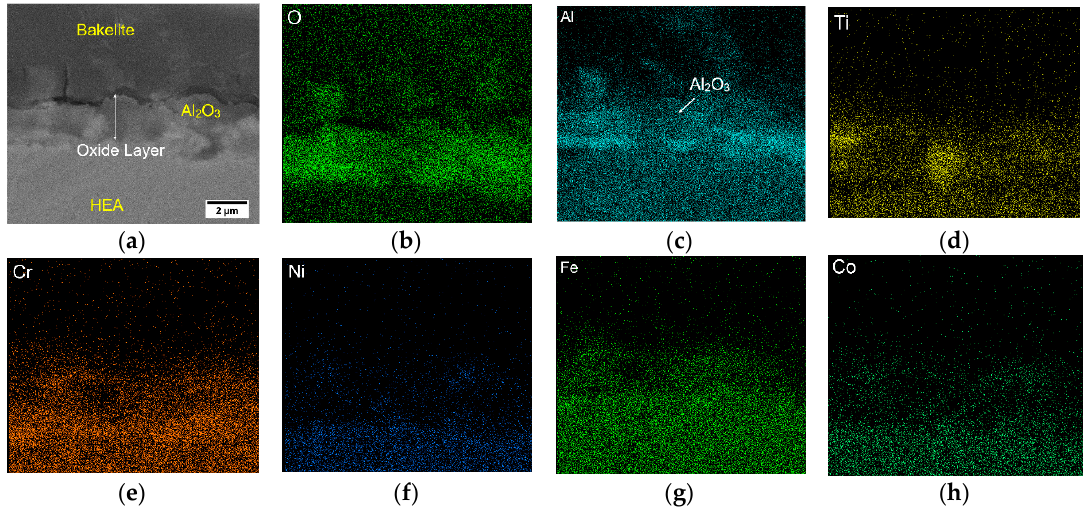
Figure 9. Cross-sectional backscattered electron images and the corresponding elemental composition distribution along the yellow arrow for the oxidized: ( a ) and ( b ) Ti6Al4V at 700 °C, ( c ) and ( d ) HEA at 700 °C, ( e ) and ( f ) HEA at 800 °C for 45 h.